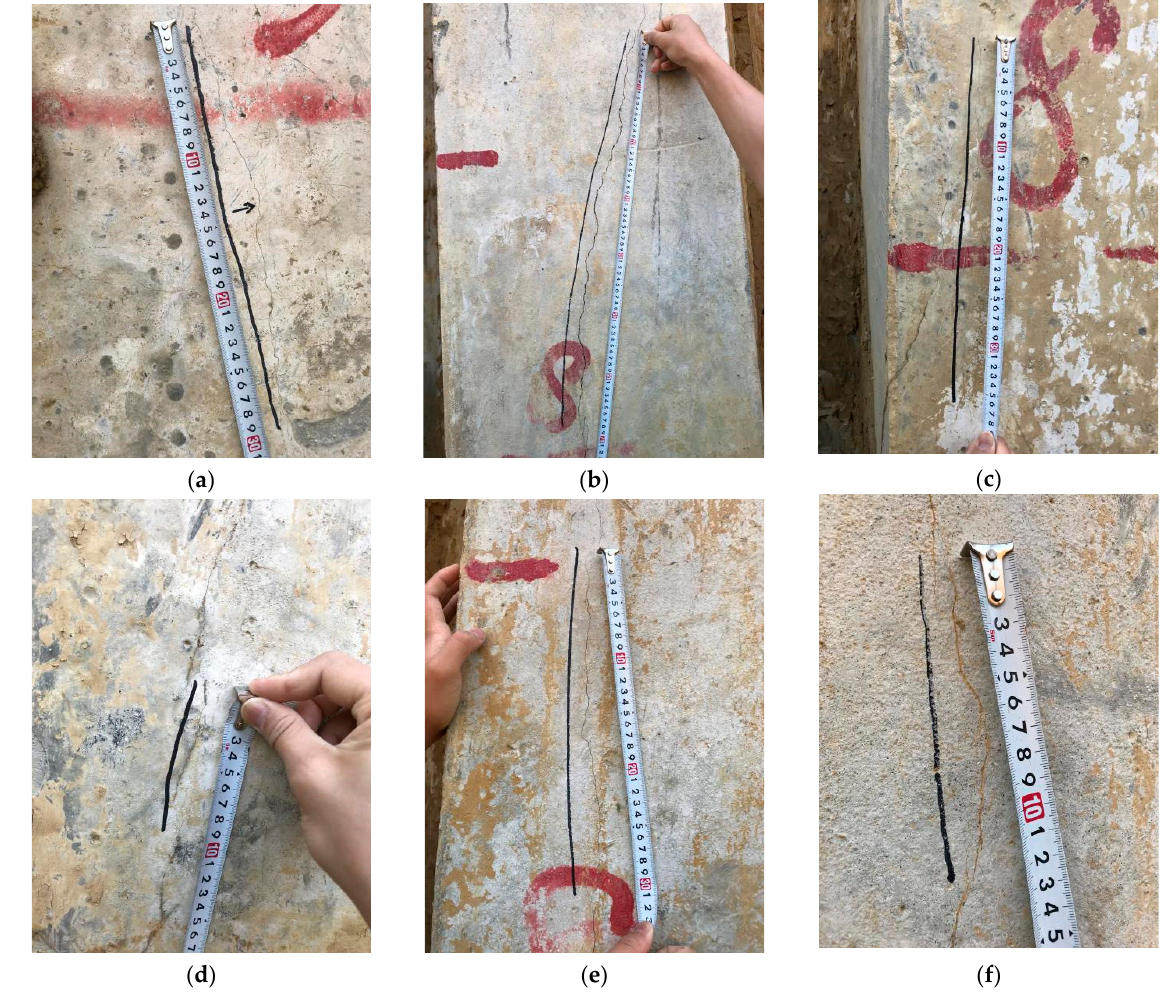
Figure 11. Crack diagram of the surface of U-shaped sheet pile #1–6 ( a ) Pile#1, ( b ) Pile#2, ( c ) Pile#3, ( d ) Pile#4, ( e ) Pile#5, ( f ) Pile#6.